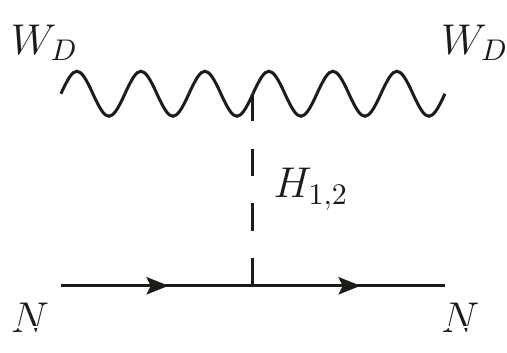
Figure 6 . DM direct detection diagram mediated by H 1 , 2